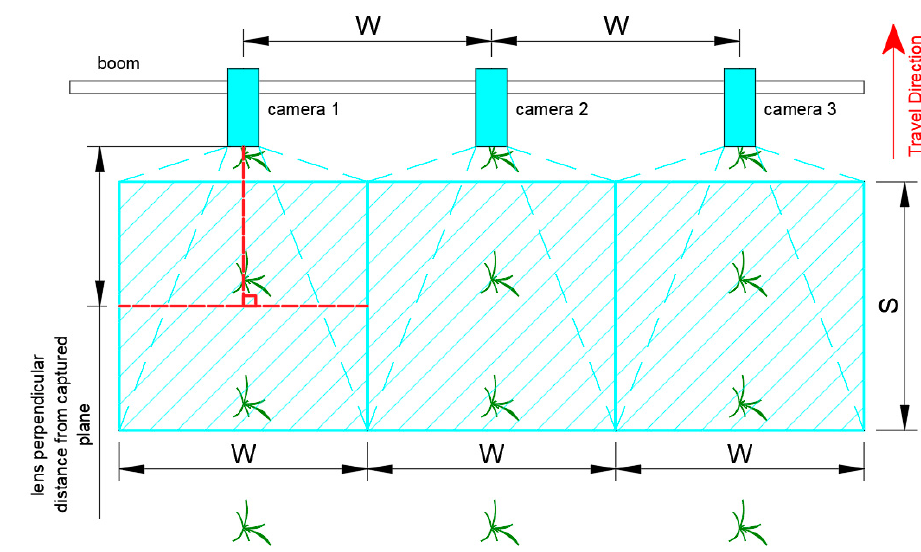
Figure 1. Camera mounting location and orientation in a boom (not drawn in scale).